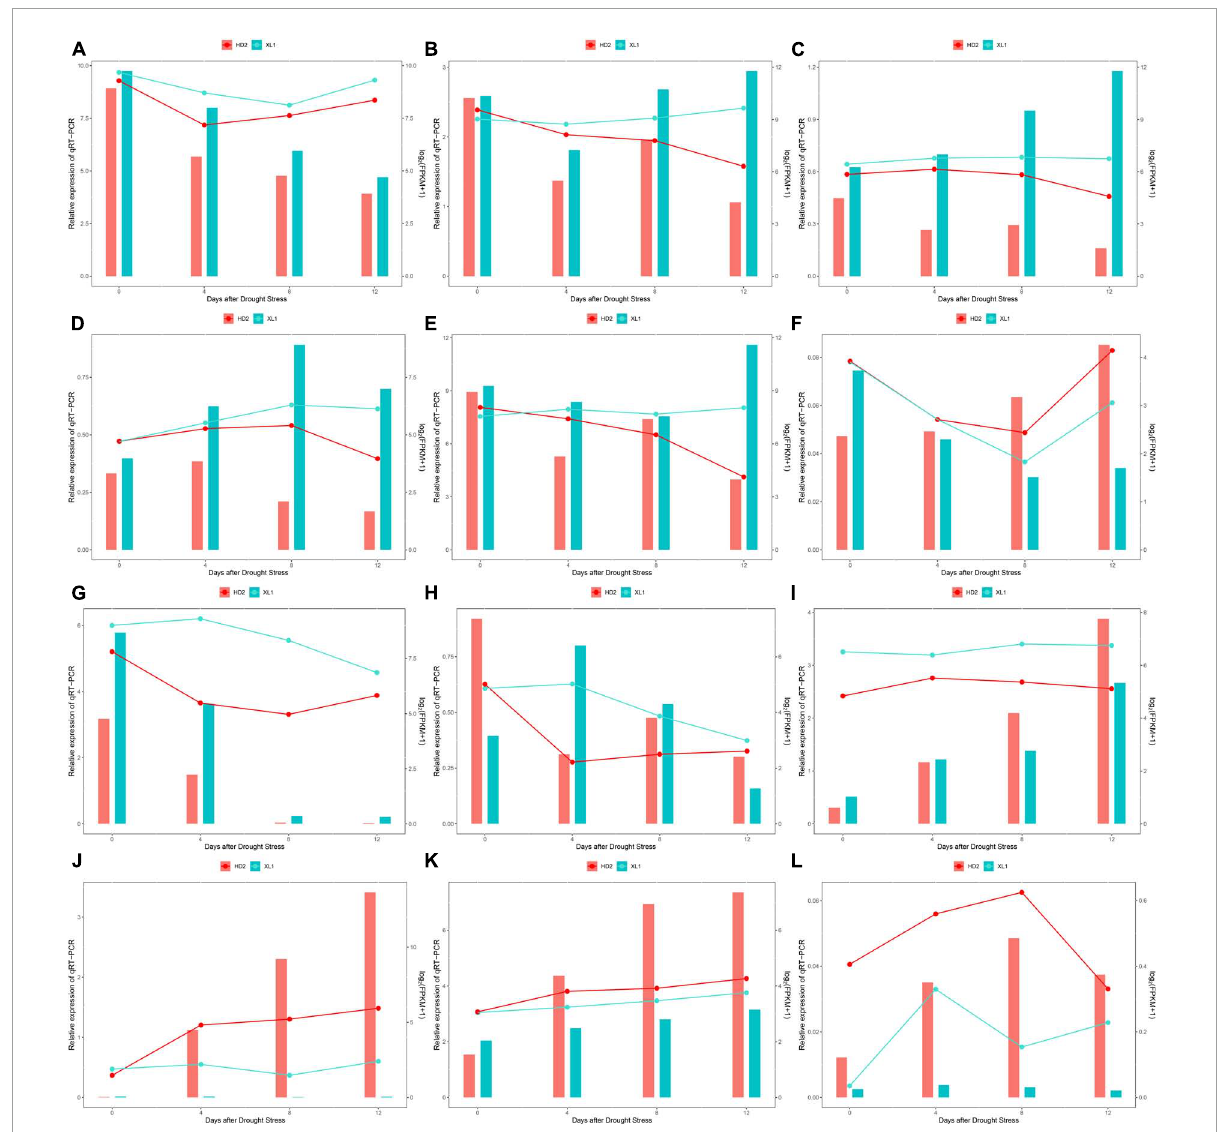
FIGURE13 The comparison of the expression levels of 6 DEGs, 3 DEMs and their target genes identified response to drought stress among mRNA-Seq/miRNA-seq (line) and qRT-PCR analysis (bar). (A) Rbcs gene expression levels during the drought stress by qRT-PCR and mRNA-seq quantifications. (B) FBA gene expression levels during the drought stress by qRT-PCR and mRNA-seq quantifications. (C) PYL6 gene expression levels during the drought stress by qRT-PCR and mRNA-seq quantifications. (D) DELLA gene expression levels during the drought stress by qRT-PCR and mRNA-seq quantifications. (E) LHY gene expression levels during the drought stress by qRT-PCR and mRNA-seq quantifications. (F) TOC1 gene expression levels during the drought stress by qRT-PCR and mRNA-seq quantifications. (G) miR398 gene expression levels during the drought stress by qRT-PCR and mRNA-seq quantifications. (H) miR408-3p gene expression levels during the drought stress by qRT-PCR and mRNA-seq quantifications. (I) miR166 gene expression levels during the drought stress by qRT-PCR and mRNA-seq quantifications. (J) DMR6 gene expression levels during the drought stress by qRT-PCR and mRNA-seq quantifications. (K) EDR2 gene expression levels during the drought stress by qRT-PCR and mRNA-seq quantifications. (L) LOC114322616 gene expression levels during the drought stress by qRT-PCR and mRNA-seq